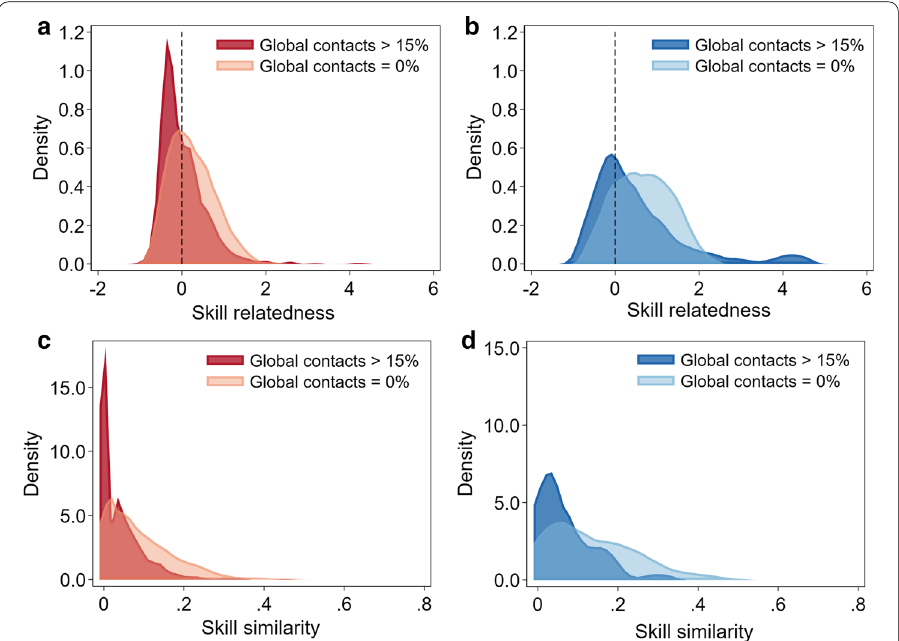
Fig. 5 Average relatedness ( a , b ) and similarity ( c , d ) of skills of persons with low|high share of global contacts. a , c All respondents; b , d co-workers within firms. Suggests decreased skill relatedness and similarity of workers with more global